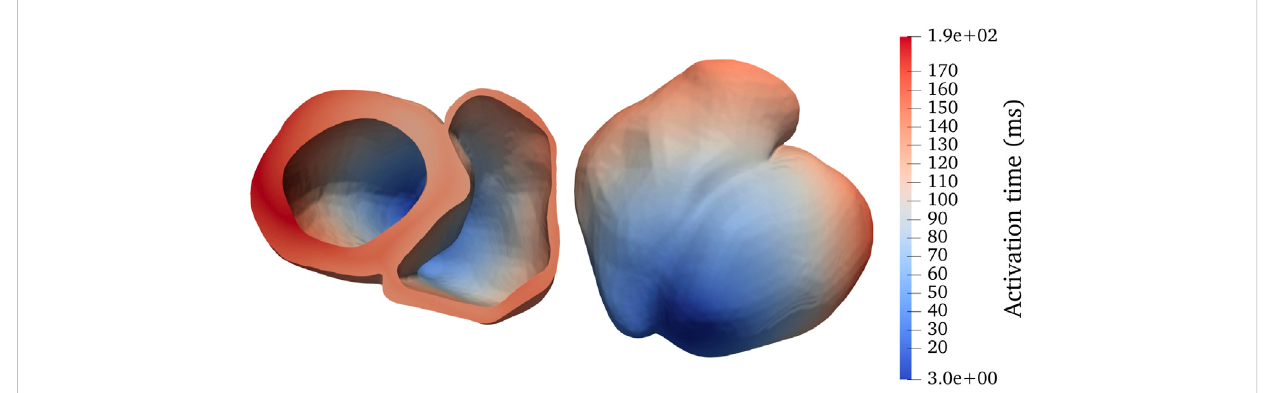
FIGURE 1 Activationmapforarealisticbi-ventricularmesh,named heart04 ,withastimulusappliedinitiallytotheapex oftheleftventricle(darkestblue).The panels show two different viewing angles of the same